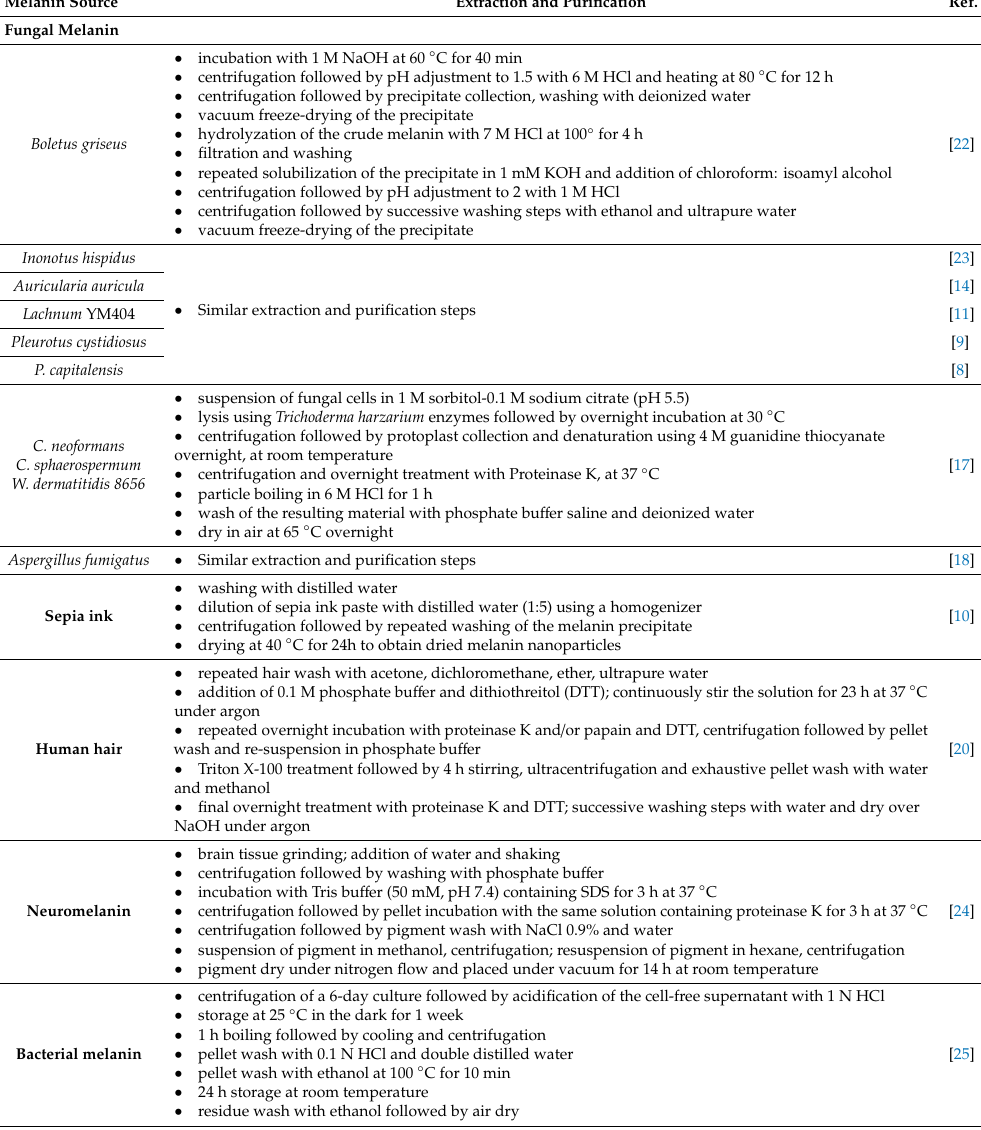
Table 1. Examples of extraction and purification procedures applied to various melanin types. Melanin Source Extraction and Purification